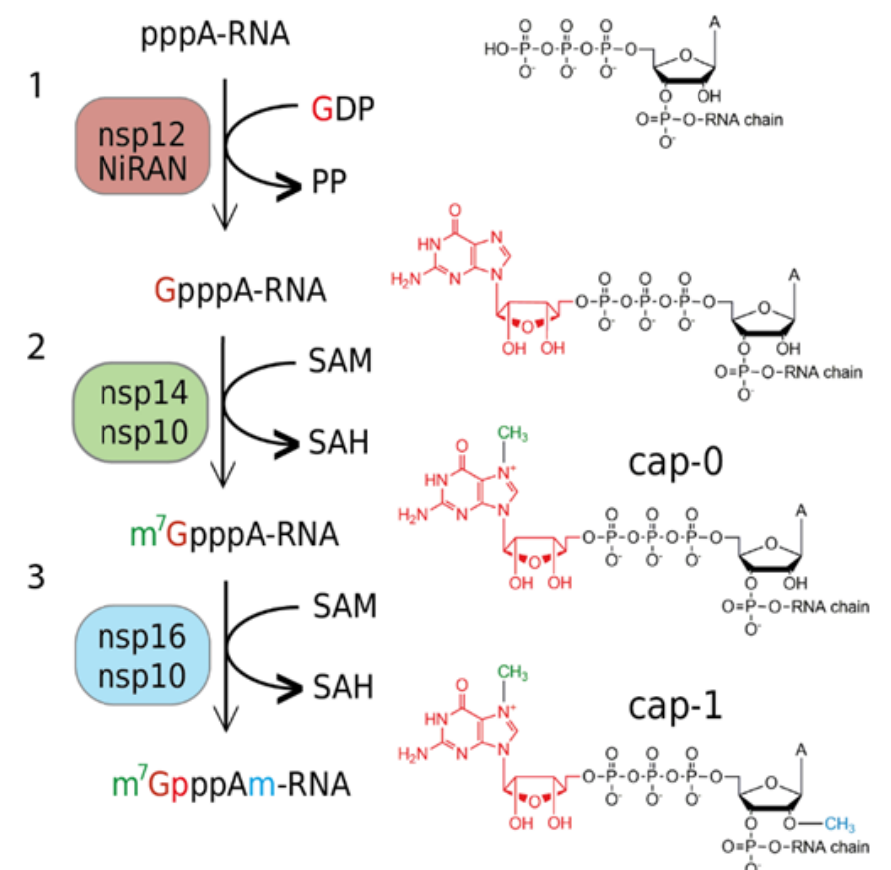
Figure 1. Overview of the cap 1 structure formation in SARS−CoV-2: ( 1 ) The NiRAN domain of nsp12 polymerase subunit catalyzes the transfer of GDP to the nascent RNA (5 (cid:48) pppA − RNA), releasing a pyrophosphate; ( 2 ) nsp14 methyltransferase with a co − factor nsp10 methylates guanosine at the N7 position and forms the cap − 0 structure (m7GpppA); ( 3 ) nsp16 in complex with nsp10 methylates ribose at the 2 (cid:48) O position of the first transcribed nucleotide to form the cap − 1 structure